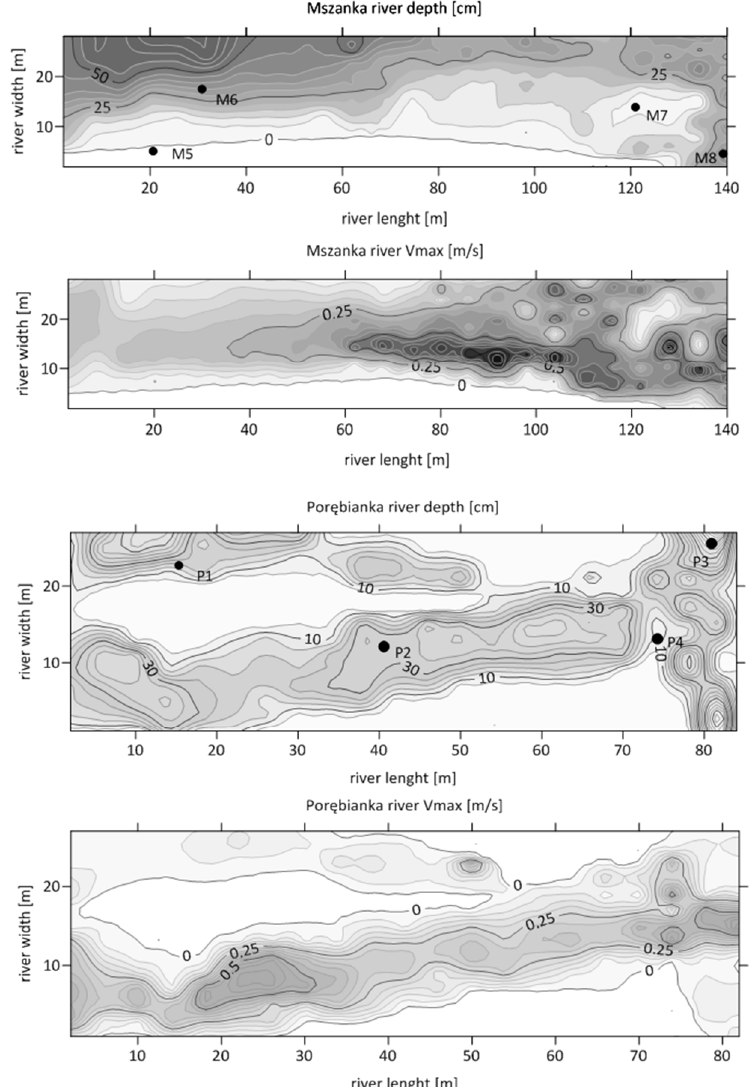
Figure 3. Flow depths and velocities in the studied Mszanka and Por ę bianka river reaches.